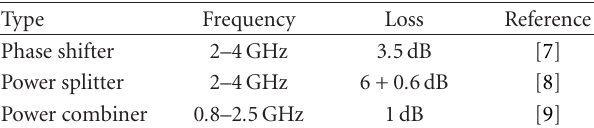
Table 1: SAS module